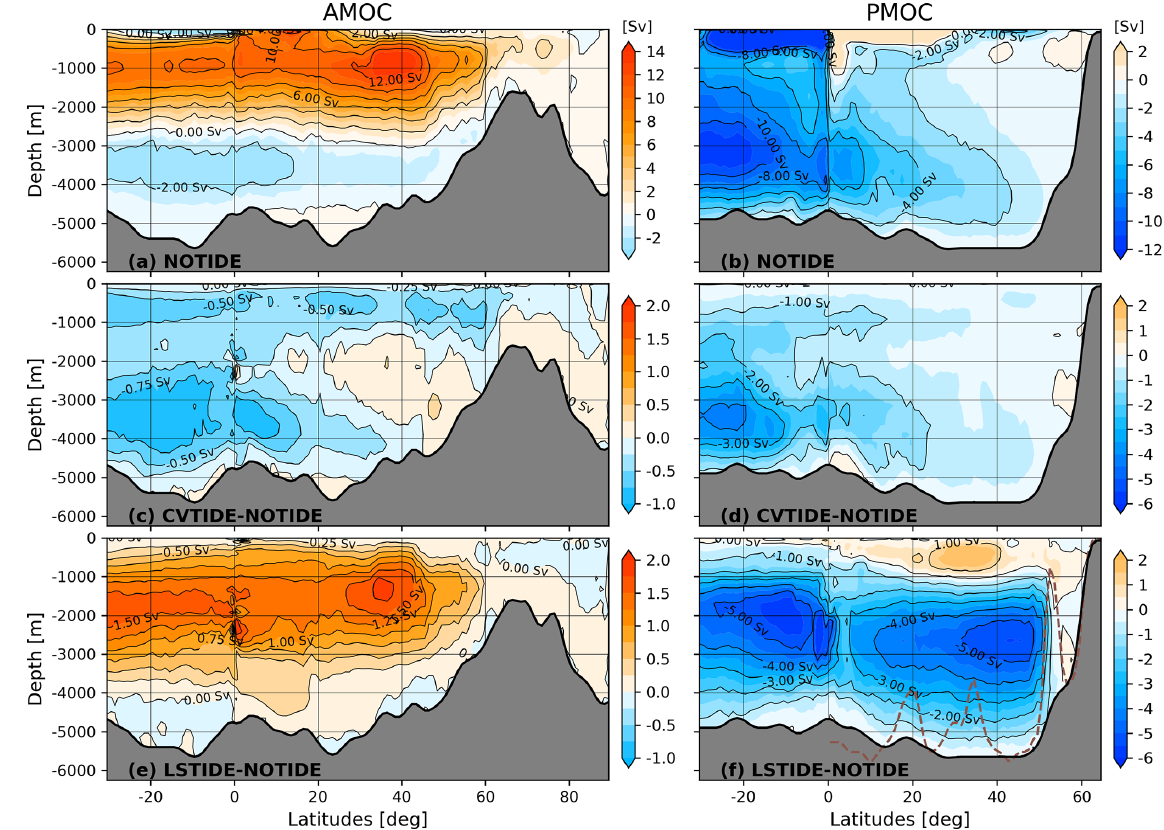
Figure 6. The MOC results in the three sensitivity runs. Panels (a) and (b) show the results from the control run, and the other panels show the differences. Panels (a) , (c) and (e) and panels (b) , (d) and (f) represent AMOC and PMOC, respectively. The dashed brown line in panel (f) denotes the North Pacific topography along the 180 ◦ transect. All the MOC contains the vertical component of bolus velocities (Gent and Mcwilliams, 1990). The calculation of MOC in the unstructured mesh applies the algorithm introduced in Sidorenko et al.